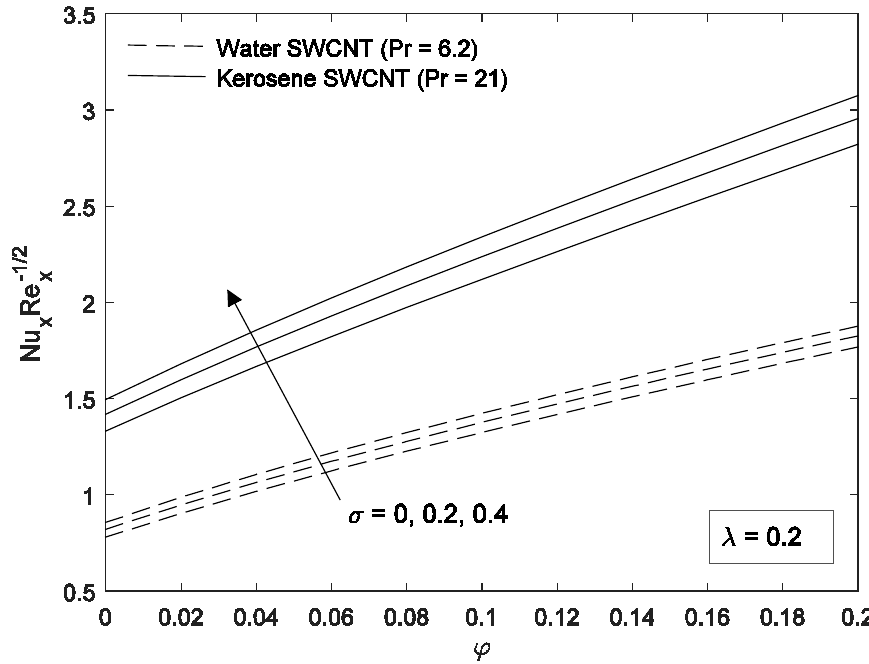
Figure 14. Effect of σ on Nusselt number for water-kerosene based fluid.